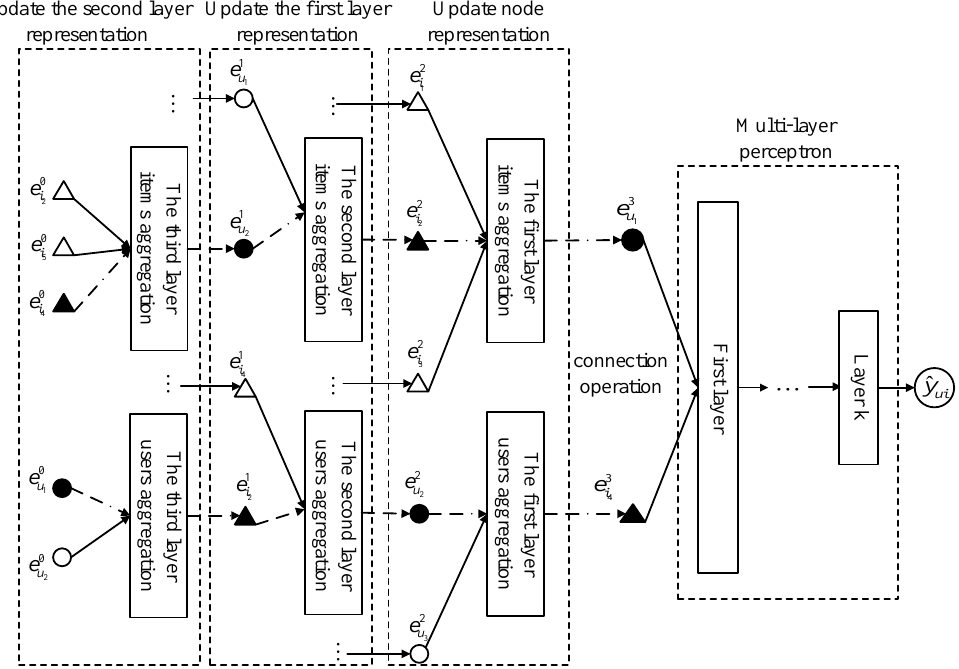
Figure 2. The process of the graph neural network recommendation algorithm.